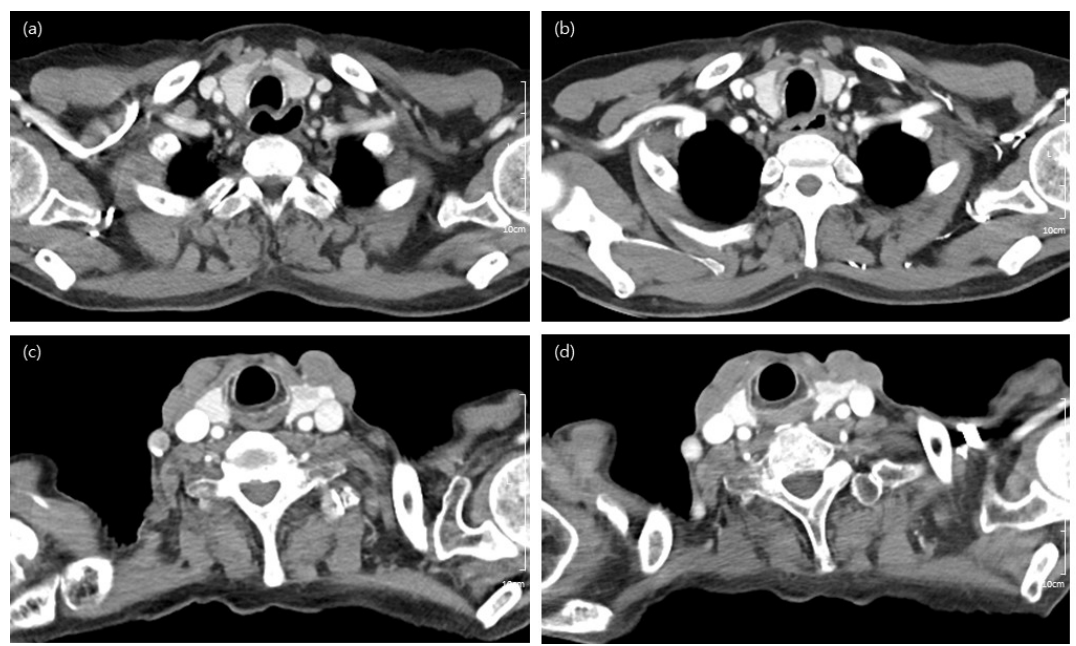
Figure 3. Computed tomography (CT) images of a 60-year-old woman obtained using low-concentration-iodine (240 mgI/mL) CM (contrast media), corresponding to Group A ( a ); follow-up image using high-concentration-iodine (320 mgI/mL) CM, corresponding to Group B ( b ). Both images have same tube voltage (100 kVp). Although there is a little streak artifact in the Group A image, both radiologists considered both images to be of good to excellent overall image quality. CT images of a 73-year-old man obtained using low-concentration-iodine (240 mgI/mL) CM and low tube voltage (90 kVp), corresponding to Group a ( c ); and follow-up image using high-concentration-iodine (320 mgI/mL) CM, corresponding to Group b ( d ). Despite the streak artifact present in the Group a image, both images were considered to exhibit good overall image quality. Table 3. Results of qualitative image analysis according to parameters. Table 4. Interobserver agreement for each